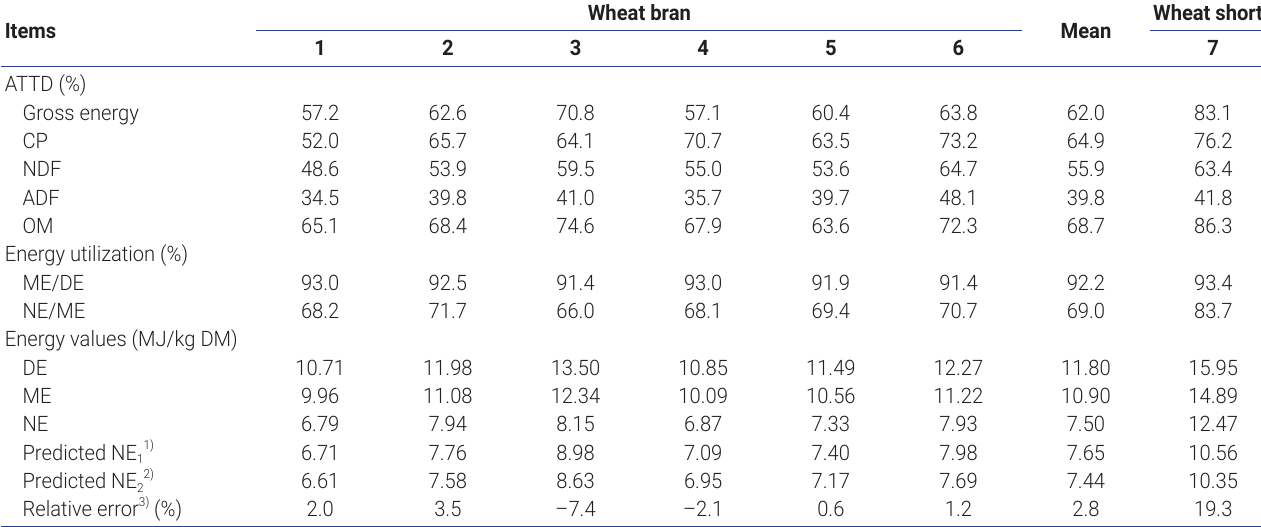
Table 5. Energy utilization and energy value of the high-fiber ingredients for growing pigs